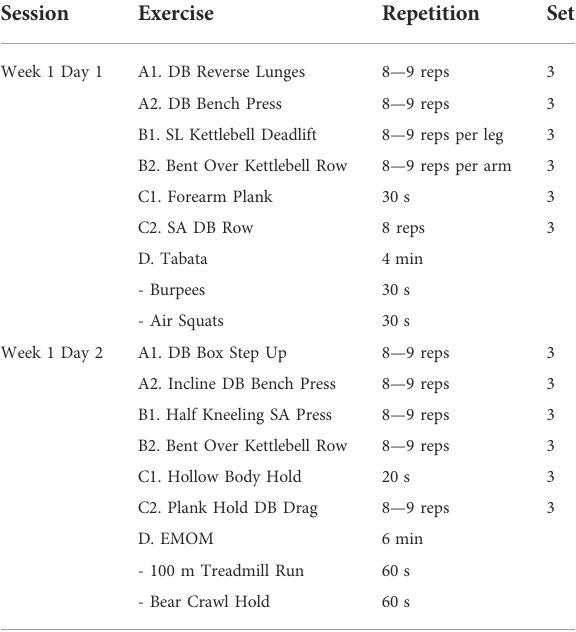
TABLE 2 Sample exercises of functional group training